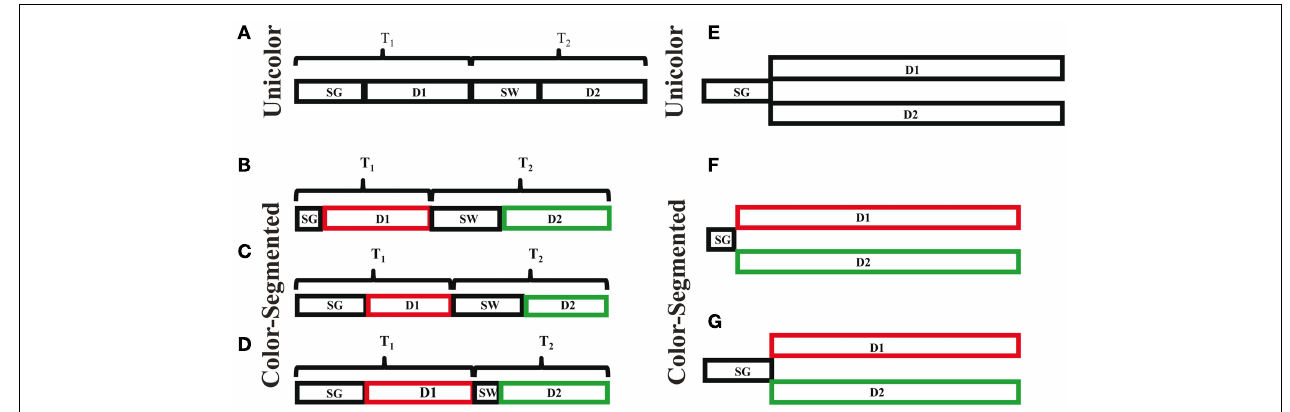
perform the task. (C) Faster motion processing hypothesis; the addition of color reduces the time needed to process the direction of each surface. Again, the total time needed to perform the task decreases. (D) Faster attentional switch hypothesis; color reduces the amount of time required to disengage attention from surface 1 and switch to processing surface 2 (SW), thus reducing the time needed to process the second surface (T2), and the total time needed to perform the task. Parallel models are depicted in (E–G) . This would eliminate the need to switch attention between objects, leaving decreased segmentation time (F) , and faster motion processing (G) , as possible mechanisms through which decreased processing time in the color-segmented paradigm could